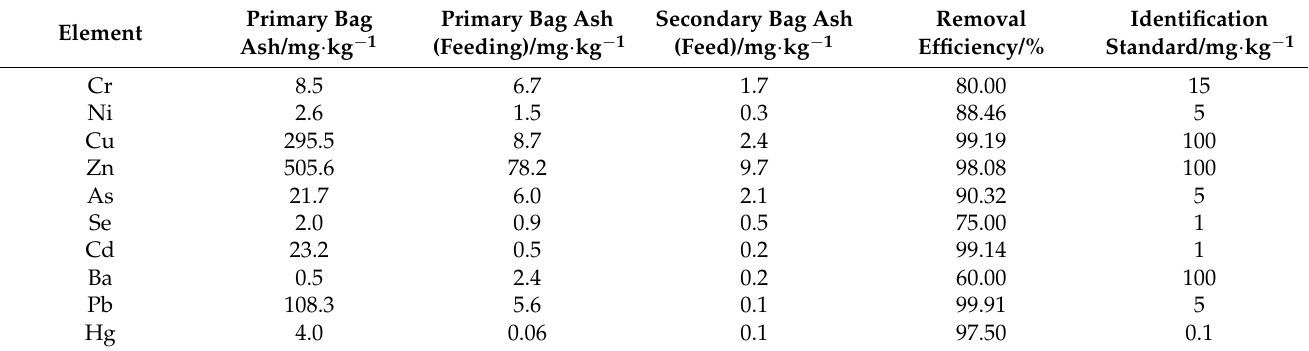
Table 2. Test results of heavy metals in three ash